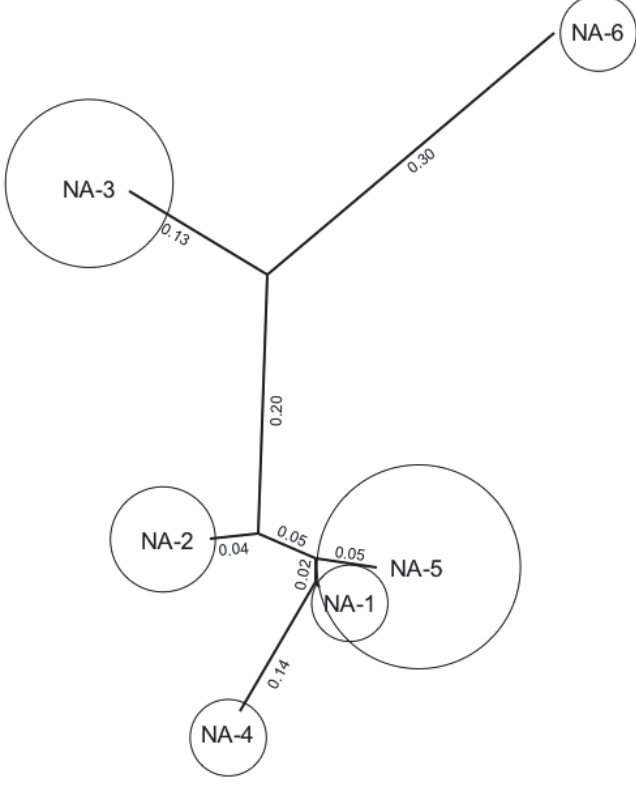
Figure 5. Neighbor joining plot of groups of Puccinia triticina isolates based on simple sequence repeat (SSR) genotypes in North America. Size of circles are approximately proportional to the number of isolates in each SSR group in the annual survey data from the US. Values between groups represent R ST